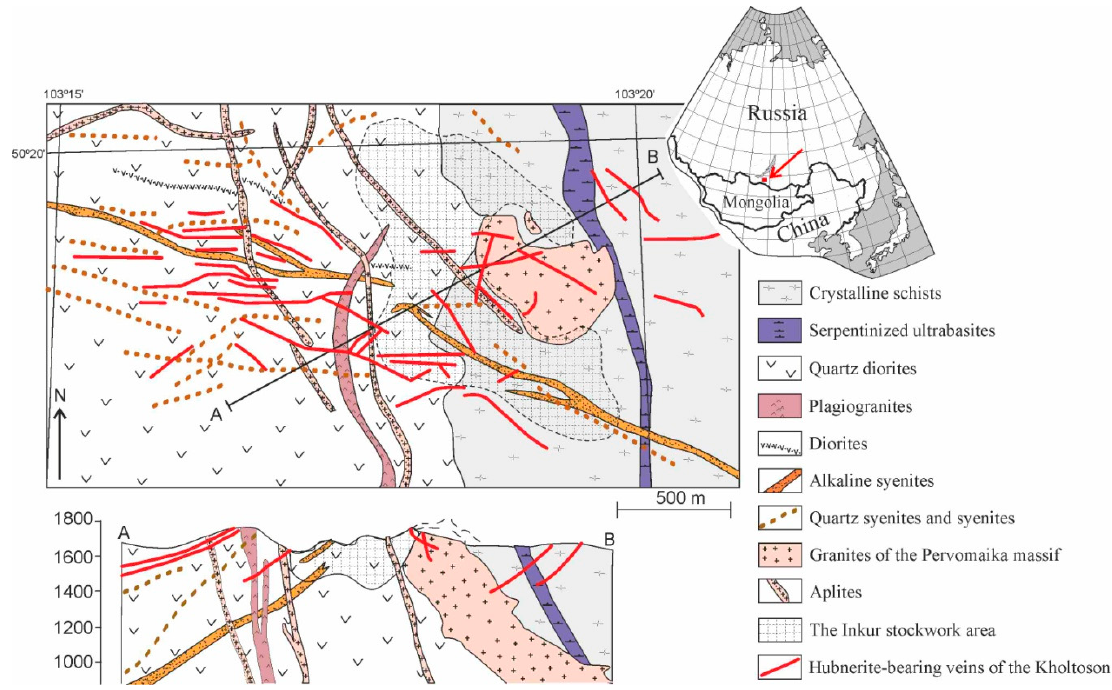
Figure 1. Geological sketch map and cross section of the Dzhida ore field after Ignatovich, 2007 [32]. The inset map shows the location of the Dzhida ore field.